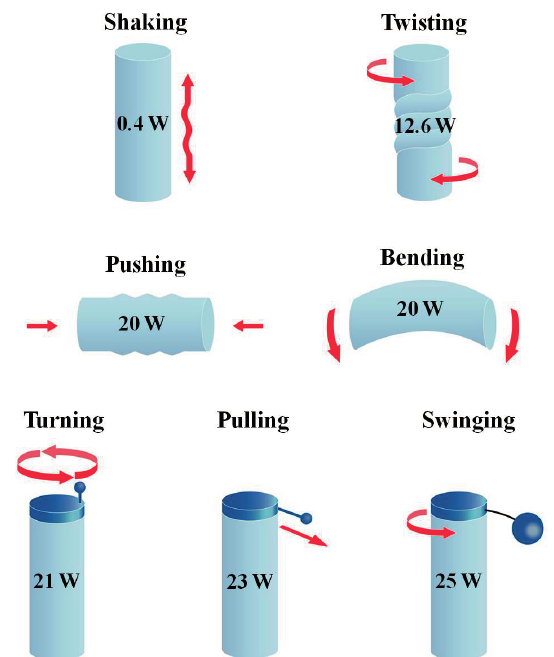
Figure 1. Power production from various upper limb